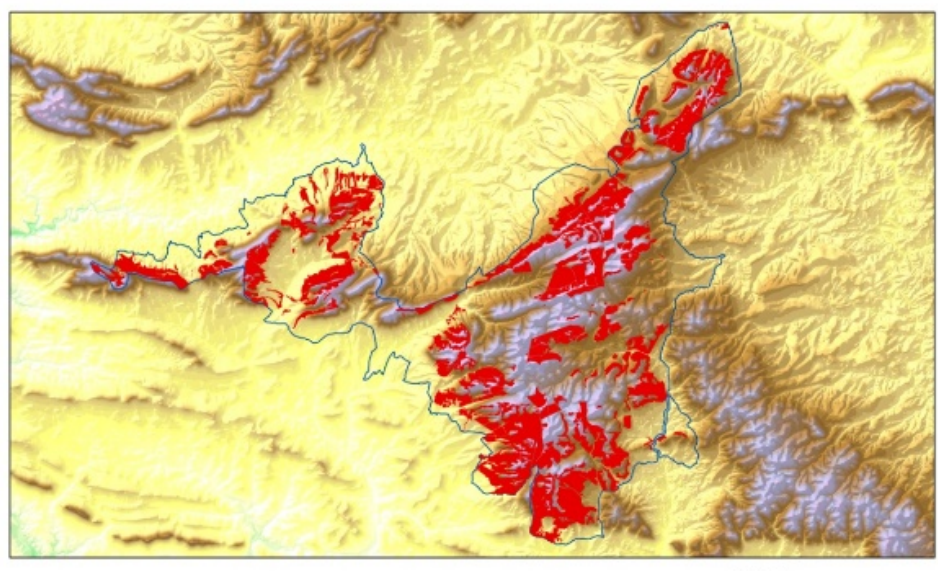
( c ) SCI: Sierra the Canalizos. Mapped associations (habitat). Red: 9330, 833013 Figure 4. ( a – c ) 9330 Quercus suber L. woods (cork oak woods). Longitude 4°36′37″ W, latitude 38°56′38″N (Saceruela). 833013 Poterio agrimonioidis-Quercetum suberis Rivas Goday in Rivas Goday, Borja, Esteve, Galiano, Rigual, and Rivas-Martínez 1960. (Sierra Morena, blue polygons; Sierra de Canalizos, red polygons). The map shows the forests of cork oak, Quercus suber , in a single plant association in sites of community interest. These forests are always located in the mesomediterranean thermotype.